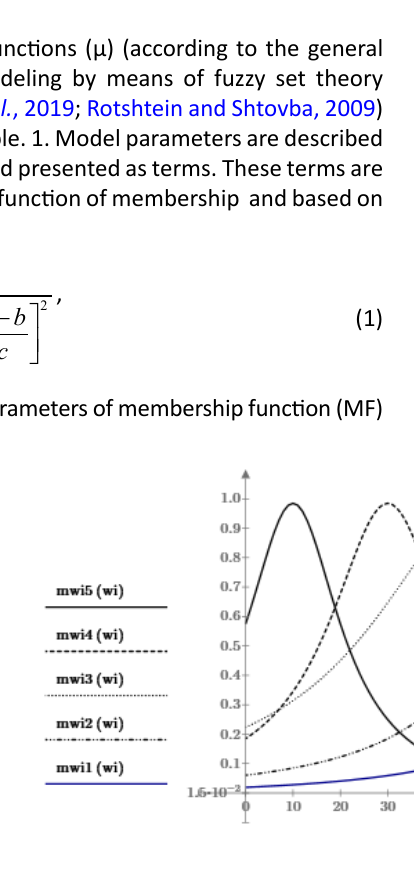
Fig. 10: The membership function for parameter WI